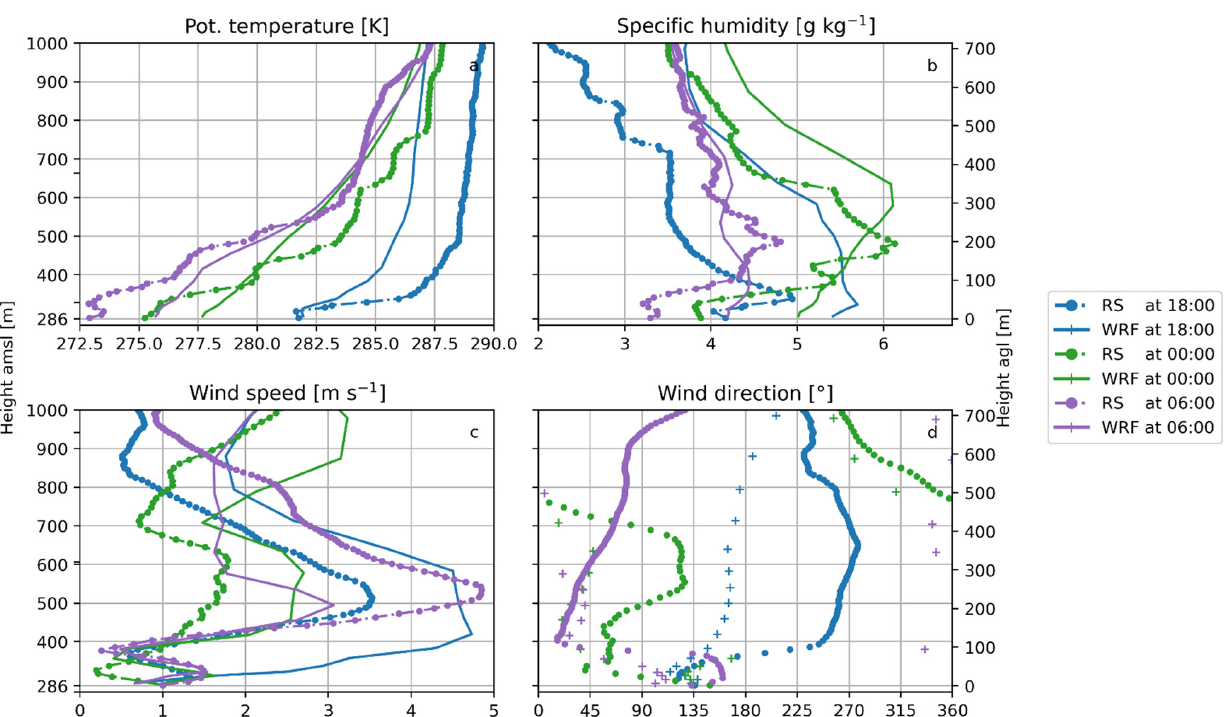
Figure 7. Radiosonde profiles and corresponding simulated profiles of potential temperature ( upper left ), specific humidity ( upper right ), and wind speed ( lower left ) and direction ( lower right ), at 18:00 UTC (blue), 00:00 UTC (green), and 06:00 UTC (violet). Dots mark observations, and continuous lines mark simulations, except for wind direction where lines were replaced with pluses at the levels of the model. The scales on y-axes are the absolute altitude (on the left) and the corresponding height above the ground (on the right).